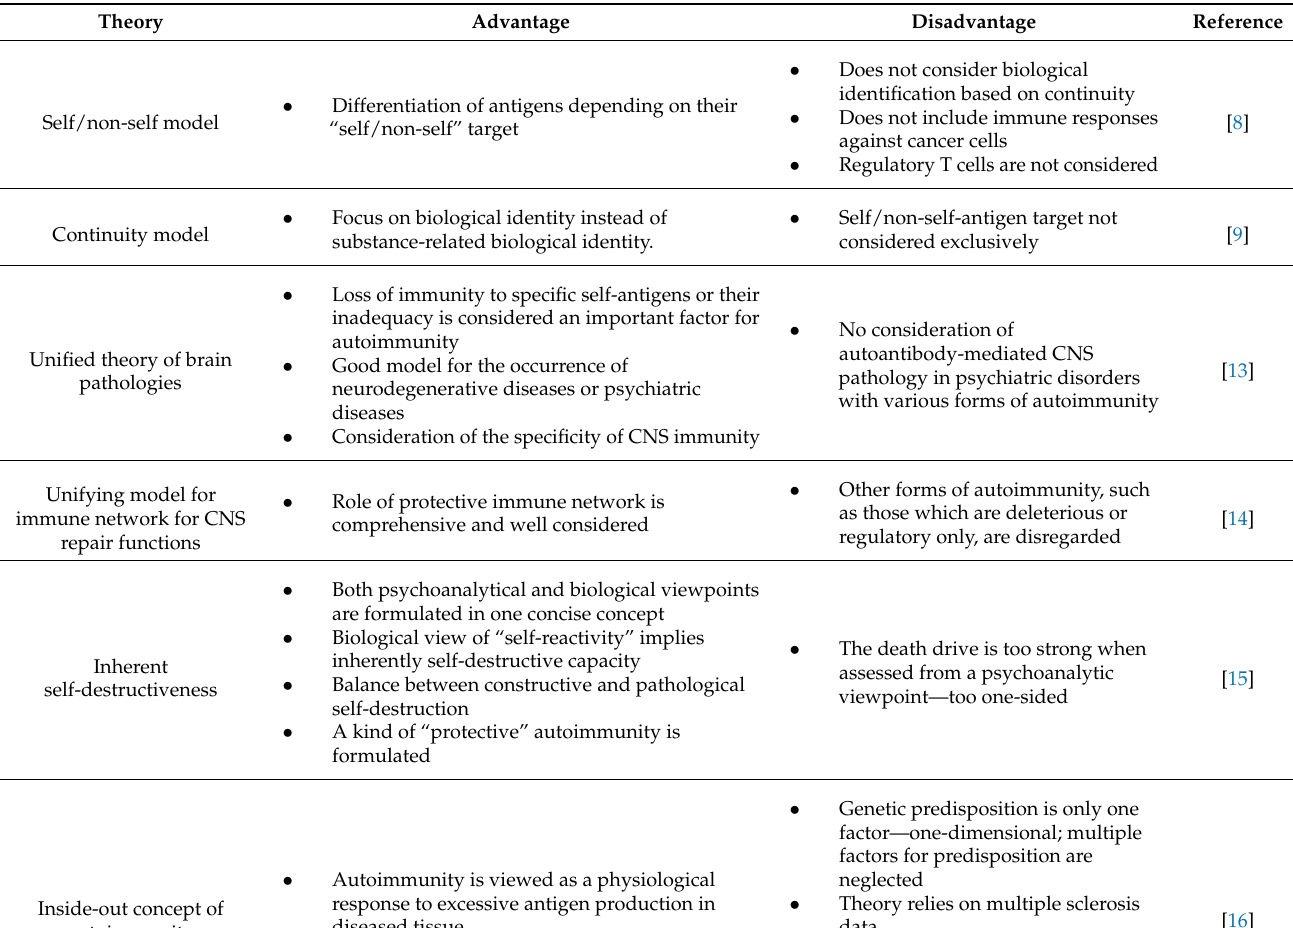
Table 1. Current concepts of CNS autoimmunity—their advantages and